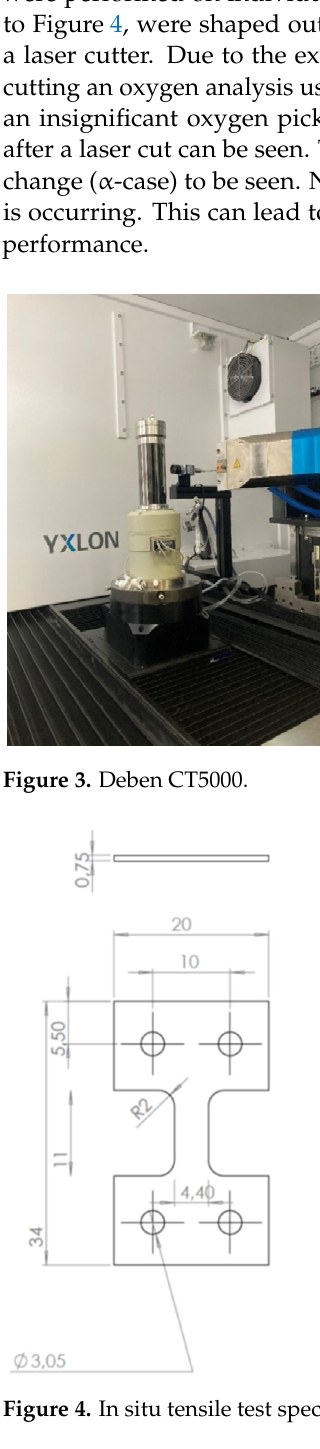
Figure 5. In situ specimen of a laser-cut EB-PBF-manufactured Ti-5553 alloy, SEM.